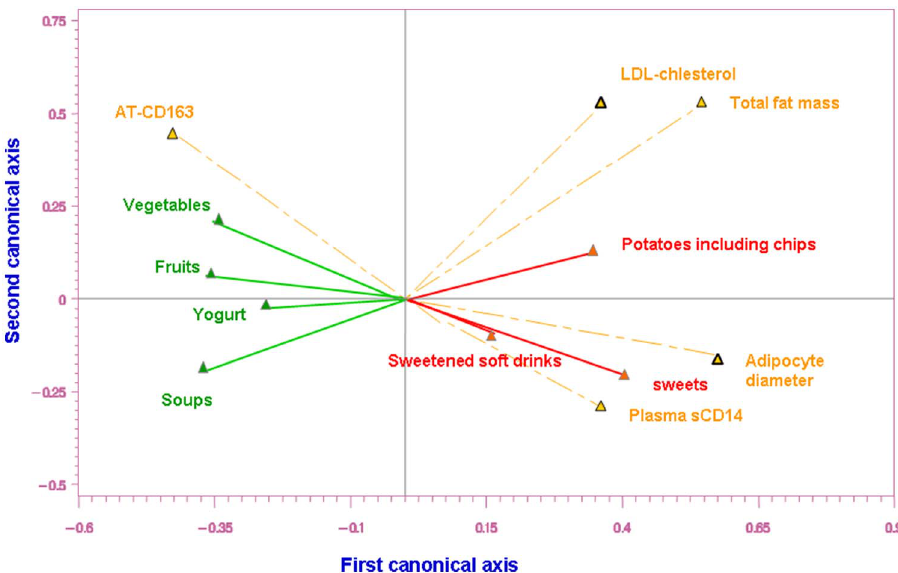
Figure 4. Canonical correlation analysis for significant food categories and selected clinical parameters (all subjects). Visualization of the association between the food categories that significantly distinguish one pattern from another and selected clinical parameters. Pairs of canonical axes were determined to maximize the covariance between the food categories and the clinical parameters. The canonical coefficients were used to assess the contributions of each food category and each clinical parameter to the correlation by evaluating their signs and magnitude. The healthy foods (yogurt, soups, fruits, vegetables) are in the area of CD163 + macrophages indicating the higher the consumption of these healthy foods, the higher the value for the alternatively (M2)-activated macrophages. The less healthy foods (potatoes, sweetened soft drinks, sweets) are in the area of LDL cholesterol, inflammatory parameters CD14, total fat mass and adipocyte diameter indicating that the higher the consumption of these foods, the higher the value of these clinical parameters; Food and clinical parameter arrows pointing in the same direction indicate positive correlation between them. The closer the food is to the clinical parameter, the greater the link (but in some cases this link is not strong, and the value for the correlation is less than 0.05).